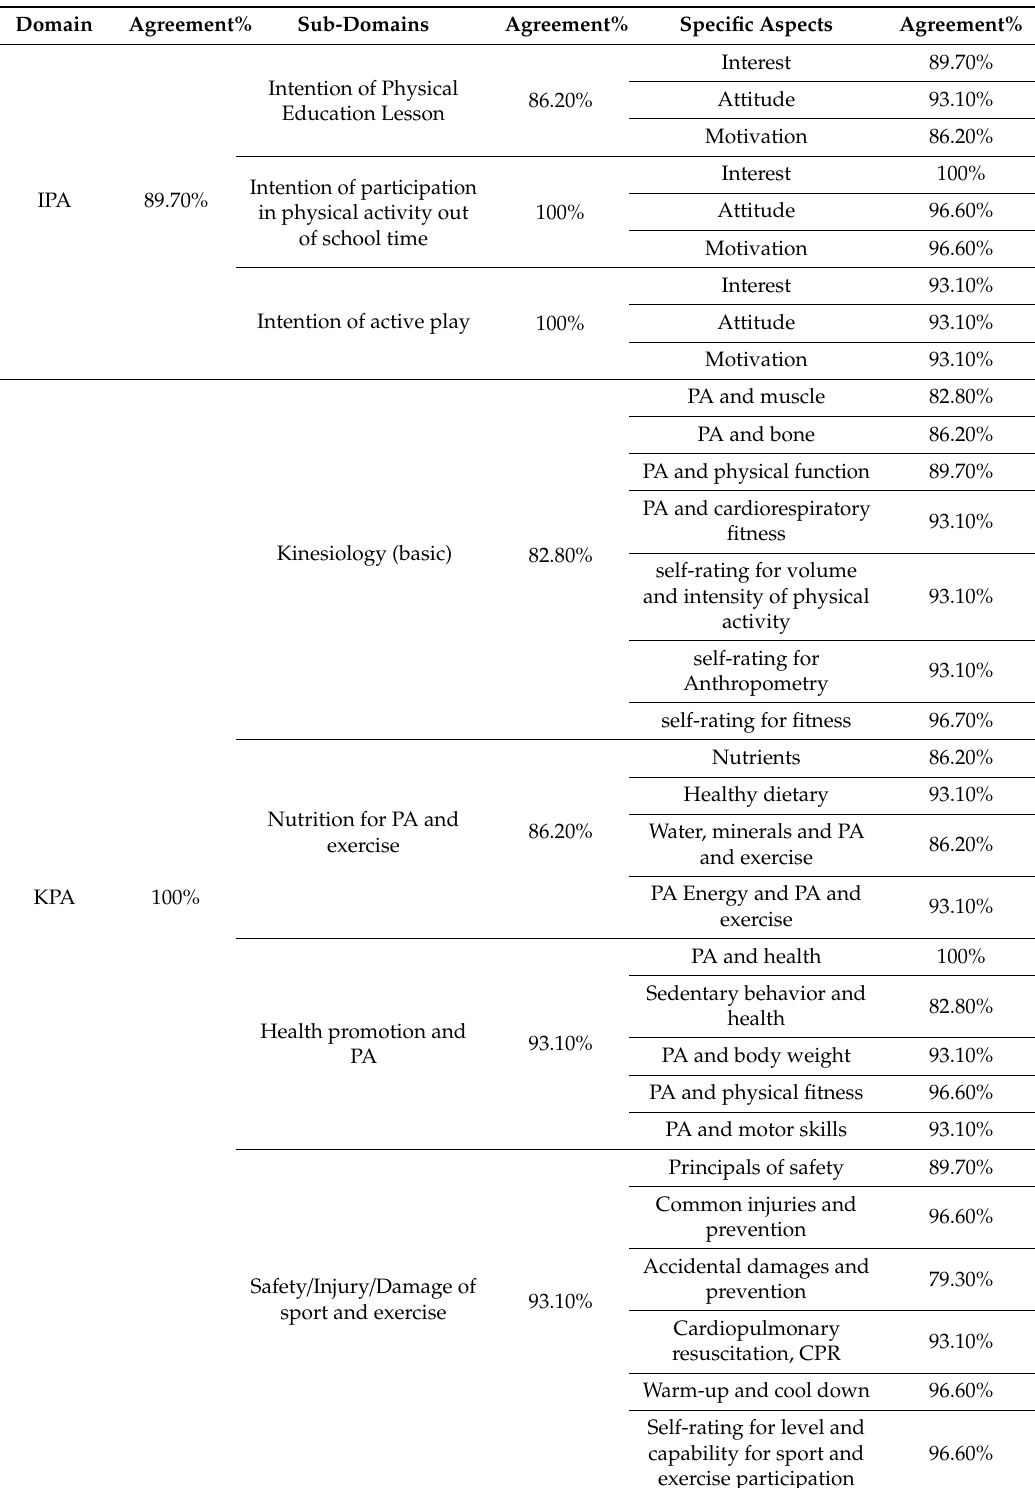
Table 2. Domain of the CAEPL and its sub-domains and specific